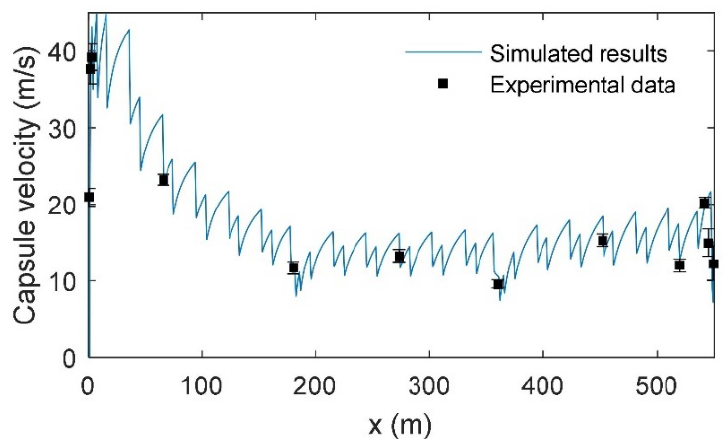
Figure 6. Simulated and experimentally measured velocity profiles of the capsule. Further analysis with simulation demonstrates viscous force, rather than the pressure force, provides the main driven force at the initial stage due to the significant velocity difference between the airflow and the capsule, as shown in Figure 7. Such a result indicates that the aerodynamic configuration should be one of the main design considerations in developing a PCP system for the purpose of obtaining efficient capsule transportation. Along with the acceleration of the capsule, the viscous force decreases rapidly. As soon as the capsule moves faster than the airflow, viscous force becomes